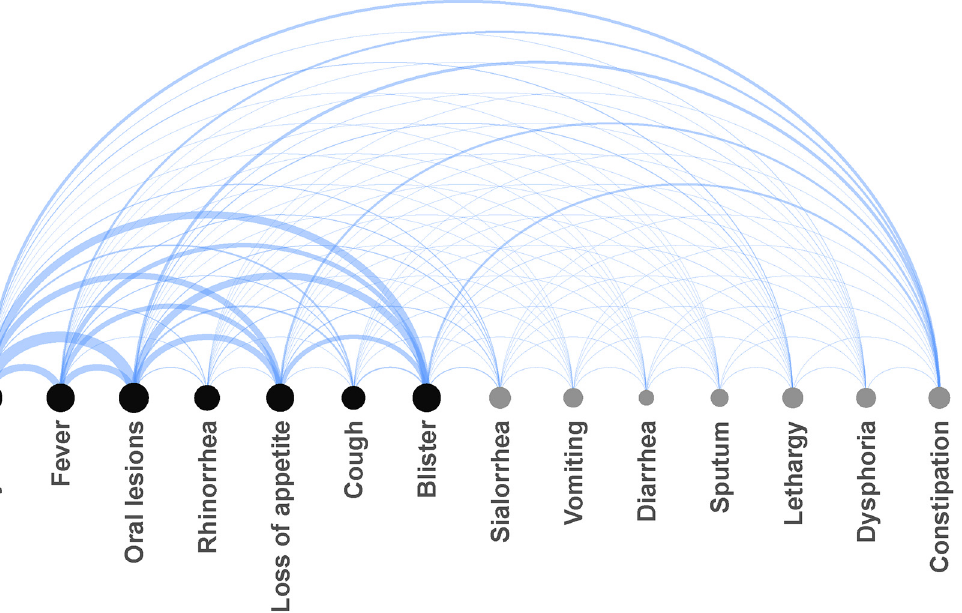
Fig 3. The arc diagram of symptoms and signs of patients with mild HFMD. The symptoms and signs were included in the guideline issued by China (black nodes, Guide Group ) or previous study (grey nodes, Potential Warnings Group ).